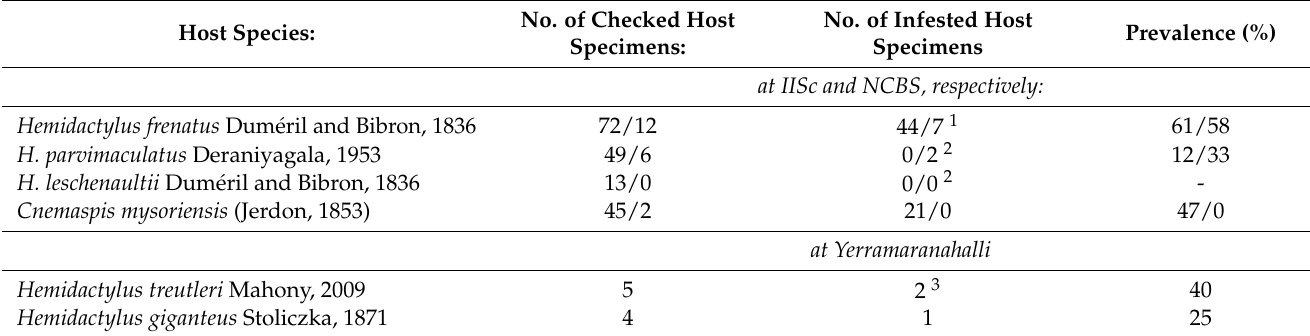
Table 3. Prevalence of Geckobia spp. in different species (specimens caught from September 2019 to November